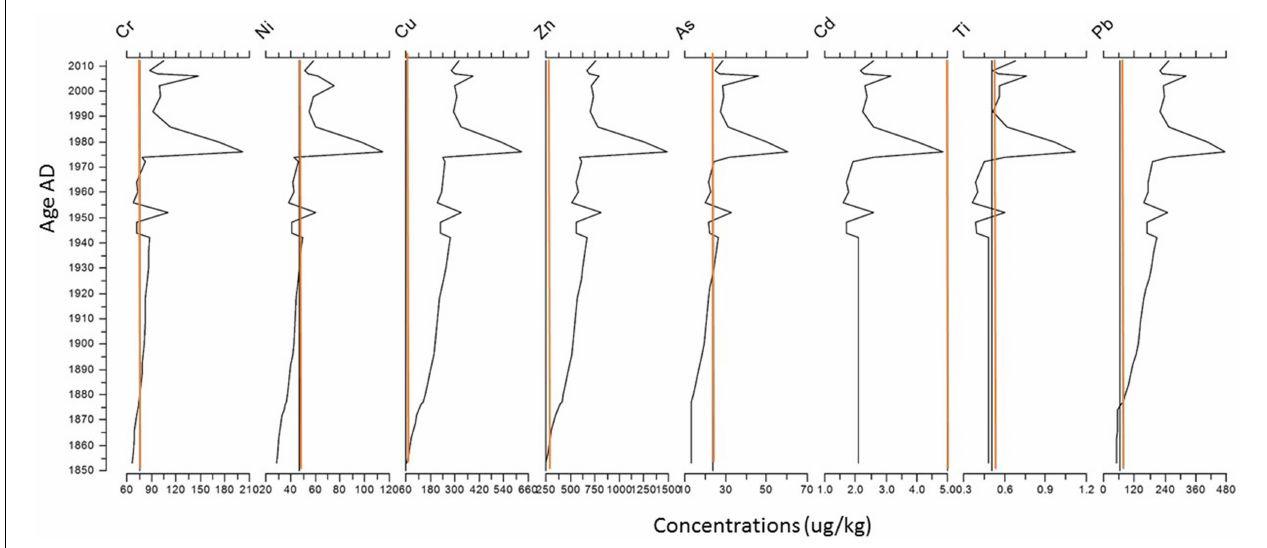
FIGURE 7 | Heavy metal concentrations. The red lines indicate levels quantified as polluted following Giesy and Hoke